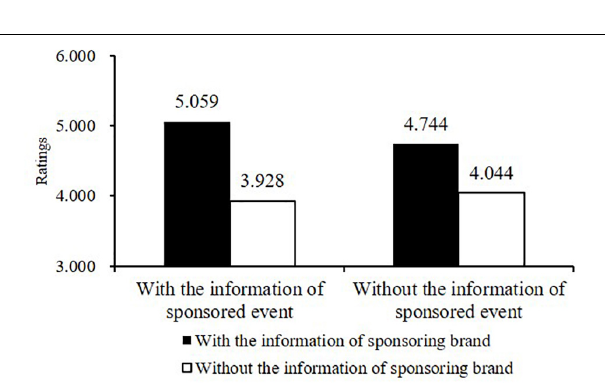
FIGURE 1 | Results of Two-Way ANOVA under the Future-Frame Condition in Study 1.